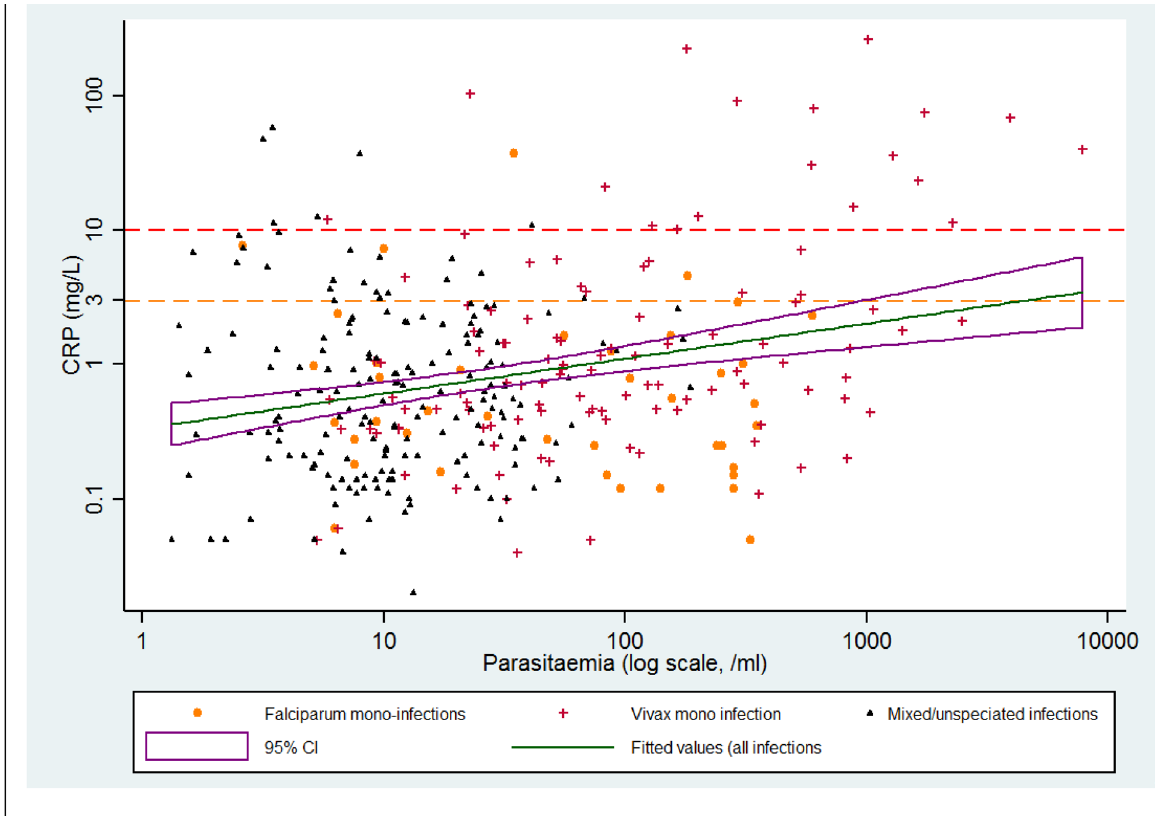
Fig 2. Scatterplot and linear prediction for the association between parasitaemia and plasma CRP concentrations.